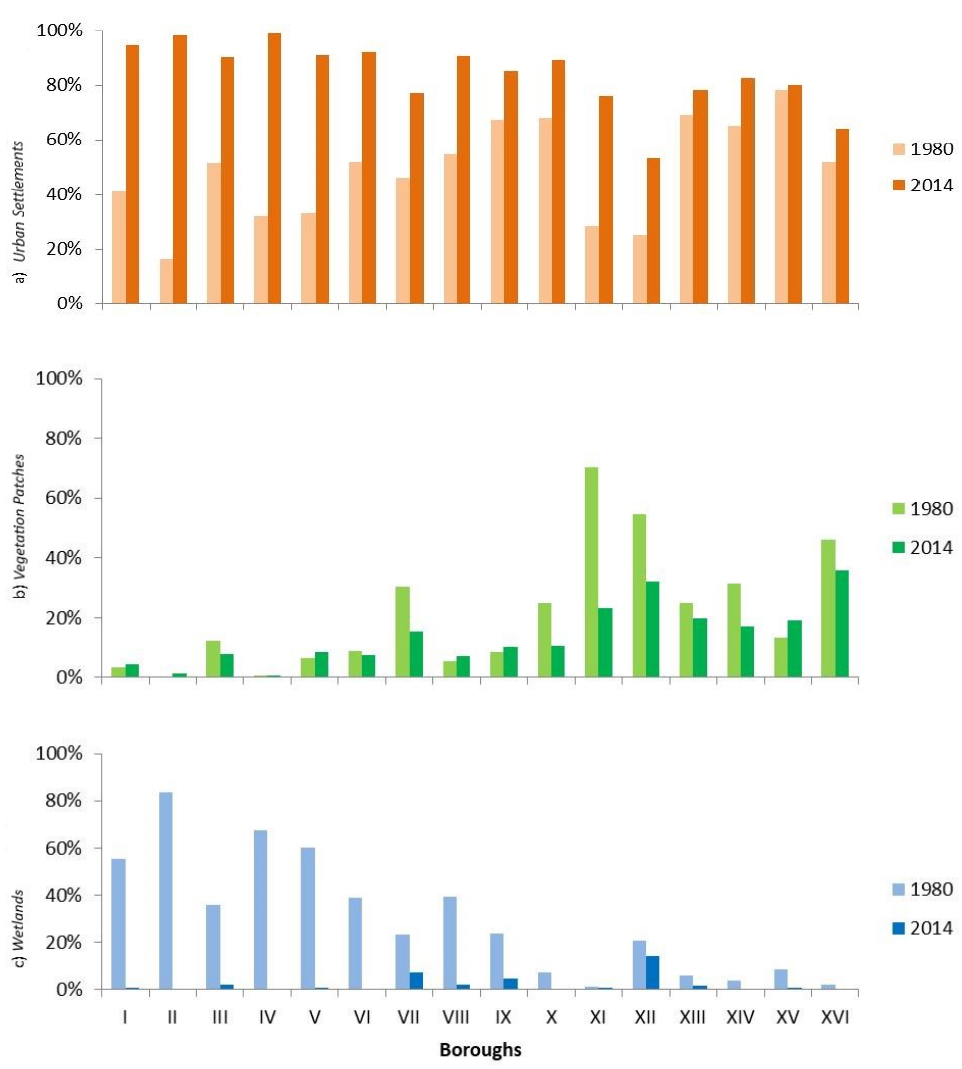
Figure 9. Borough wise differentiated relative distribution of major land use-land cover classes in Kolkata Municipal Corporation area (KMC) in 1980 and 2014. Major land use-land cover classes are shown differentiated by in (a) urban settlements , (b) vegetation patches , and (c) wetlands . (Data base courtesy: Satellite Image interpretation from Landsat (USGS) and LISS III series (ISRO, India) and the Govt. of West Bengal, India).